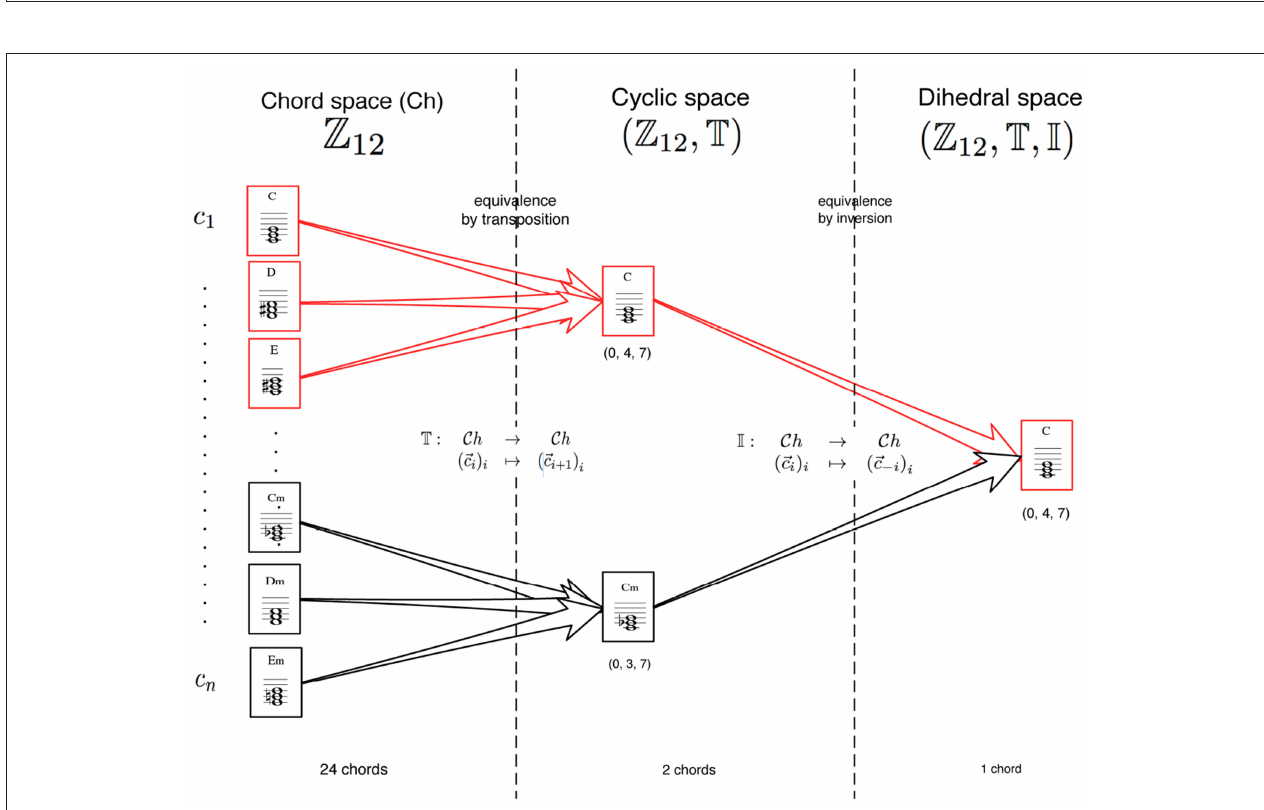
FIGURE 5 | Example of chord progression estimation enhanced with semantic structure information. Extract of the Pink Floyd song Breathe . The first 4 lines (beats, downbeats, chords, structure) correspond to the ground truth annotations. The next two lines show the results obtained with models proposed in Papadopoulos and Tzanetakis (2017), designed to obtain a “structurally consistent” chord transcription. The 5th line shows the results obtained with a baseline chord HMM, considering only chroma observation and transitions between successive chords. The last line shows the results obtained with a model that adds long-term chord dependencies: it favors same chord progressions for all instances of the same segment type (see the corresponding graphical model in Figure 11 below). The ground-truth chord of the first bar of the verse is an Em chord. The baseline chord HMM correctly estimates the second instance of this chord, but makes an error for the first instance (EM instead of Em). This is corrected by the model that favors same chord progression in same segment